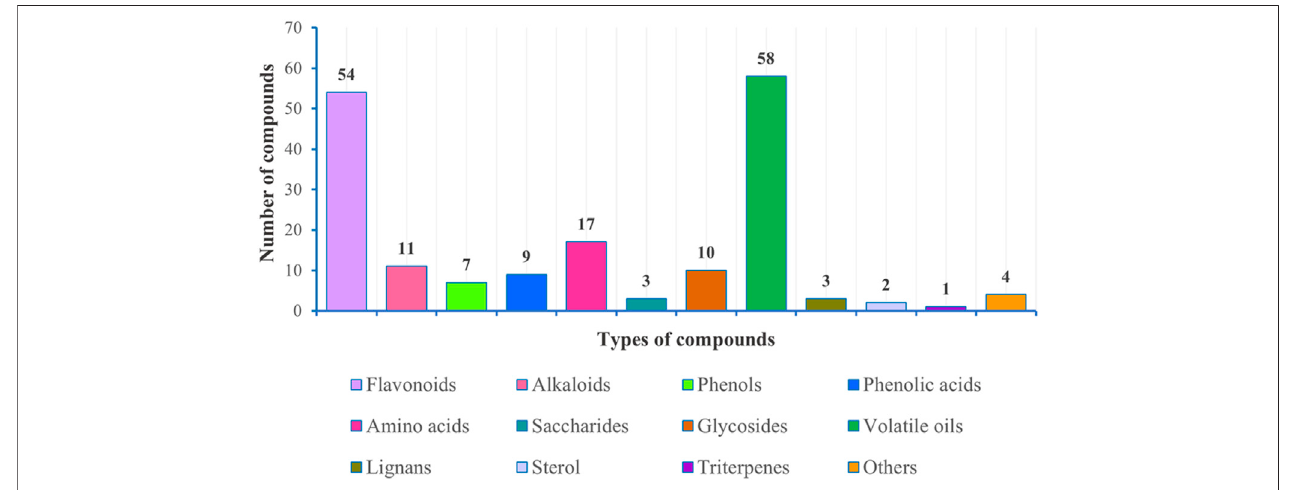
FIGURE 11 | Percentage of compounds in different parts of A. sparsifolia .